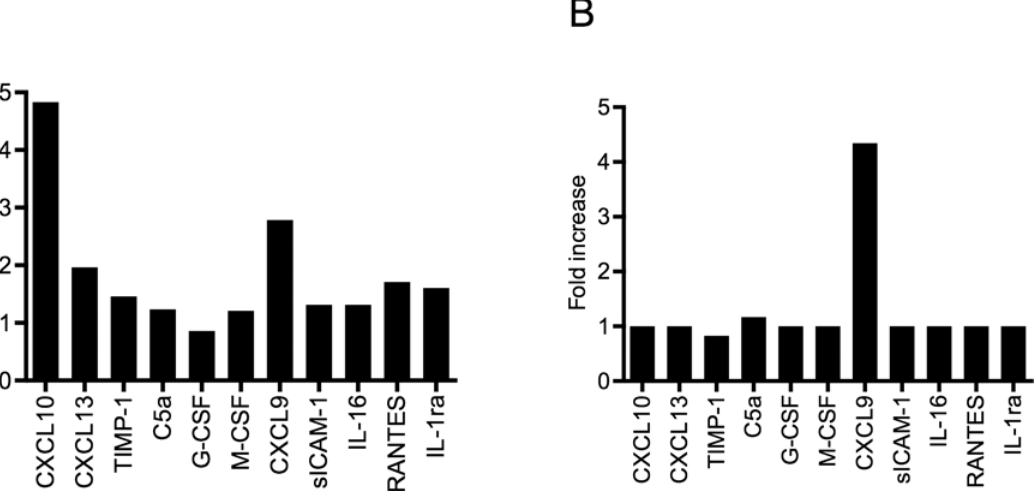
Fig 7. Intravenous injection of CTHs triggers the systemic release of CLXC9 and CXCL10. CTHs (25 mg/kg body weight) or PBS was injected intravenously into Balb/c mice (5 mice per group). After 4h (A) and 24h (B), mice were euthanized and blood samples were recovered by cardiac puncture followed centrifugation. The resulting plasma samples from each group were pooled and analyzed using a mouse multi-cytokine array (n = 1). Mean pixel densities were quantified by Image Lab 4.1 (Bio-Rad Laboratories, Berkeley, CA, USA).